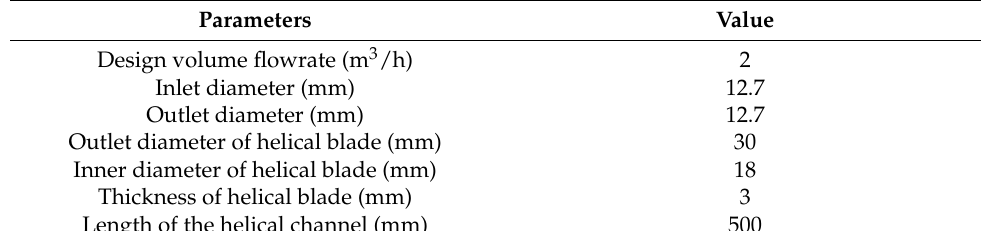
Table 1. The main parameters of compact electrostatic coalescer. Figure 1. Structure of compact electrostatic coalescer with helical electrodes. ( a ) 3D assembly model ; ( b ) cross-section view of the assembly .